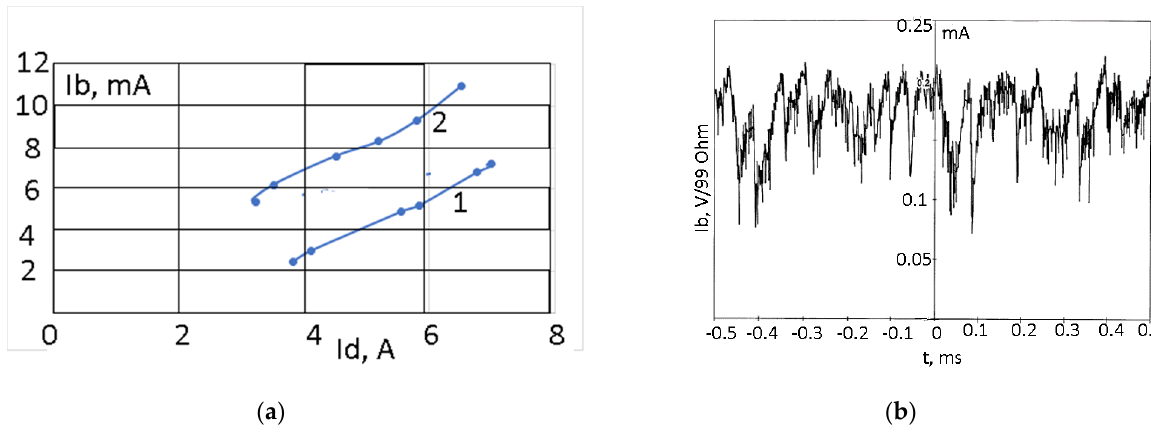
Figure 3. Schematic of experimental implanter for testing the small anode ion source. 1—extractor, 2—ion source, 3—tunnel, 4—gas injection, 5—analyzer magnet, 6—scanning magnet, 7—collima- tor magnet, 8—wafer holder.